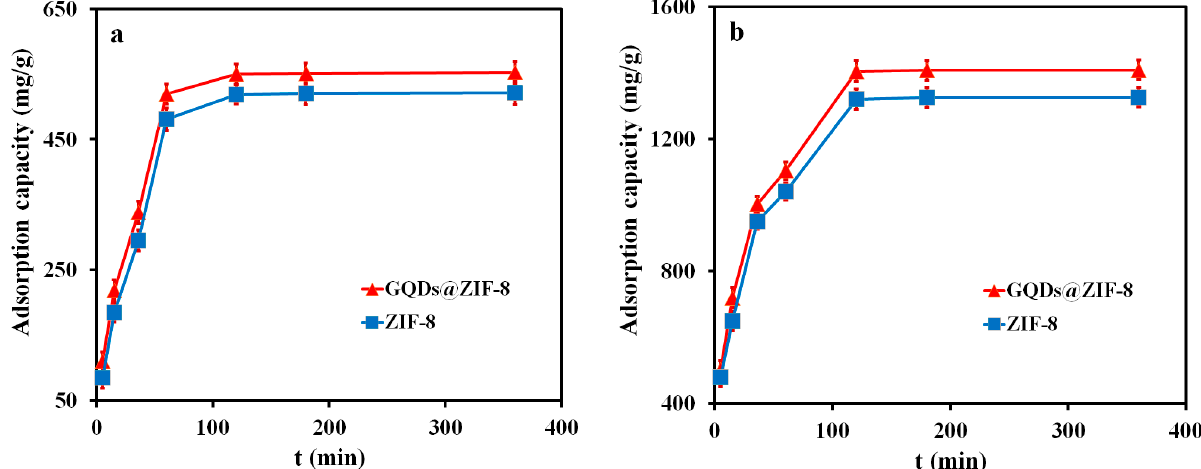
Figure 10. Effect of contact time on the adsorption properties of toluene ( a ) and ethyl acetate ( b ). To investigate the cyclic adsorption properties of the GQDs@ZIF-8 composites, five adsorption-desorption cycles were conducted, and the adsorption capacities after each cycle were measured, as shown in Figure 11. To carry out the desorption process, the samples that experienced adsorption were heated in a tube furnace to 150 ◦ C for 1 h, with a N 2 flow of 0.2 L/min as the protection gas, then the samples were taken out to